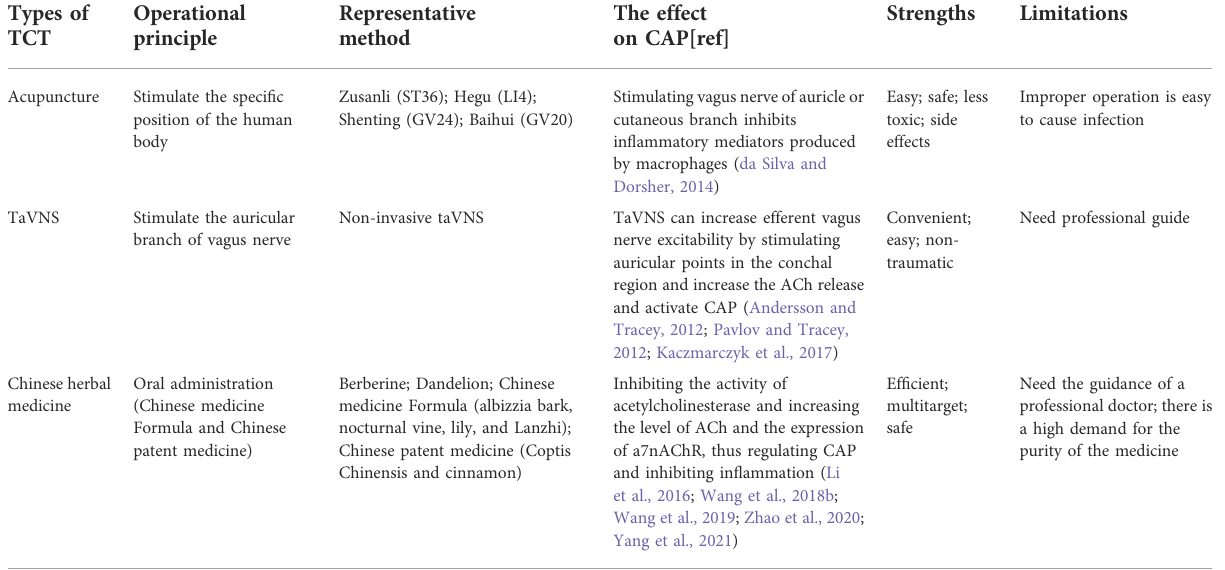
TABLE 2 Summary of TCT ’ s effect on CAP and their advantages and